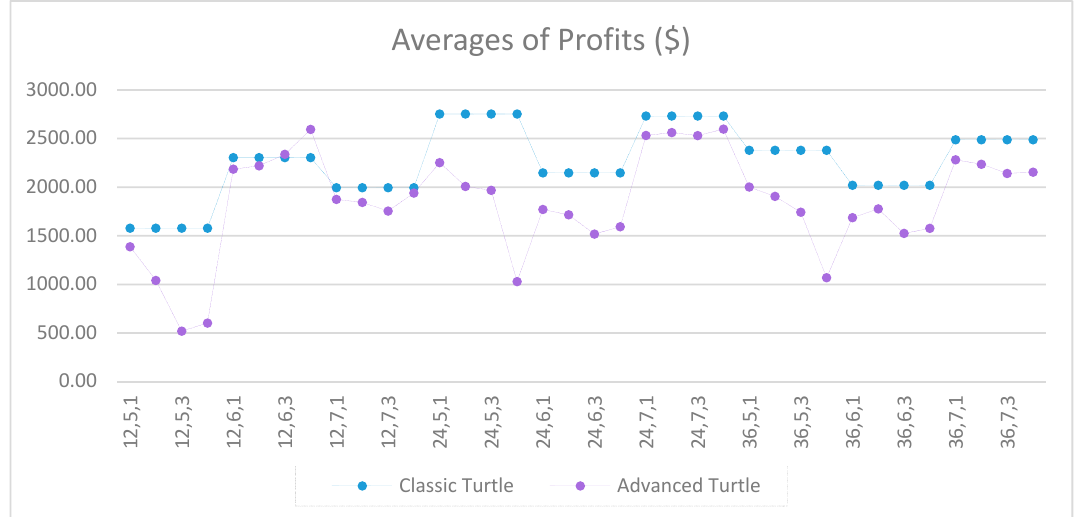
Figure15. AveragesofprofitsbetweentheclassicandtheadvancedTurtlesystemsforeverycombination Figure 15. Averages of profits between the classic and the advanced Turtle systems for every of N, X, Y for the slow parameters (80, 160), where X ≥ combination of N, X, Y for the slow parameters (80, 160), where X ≥ 5.